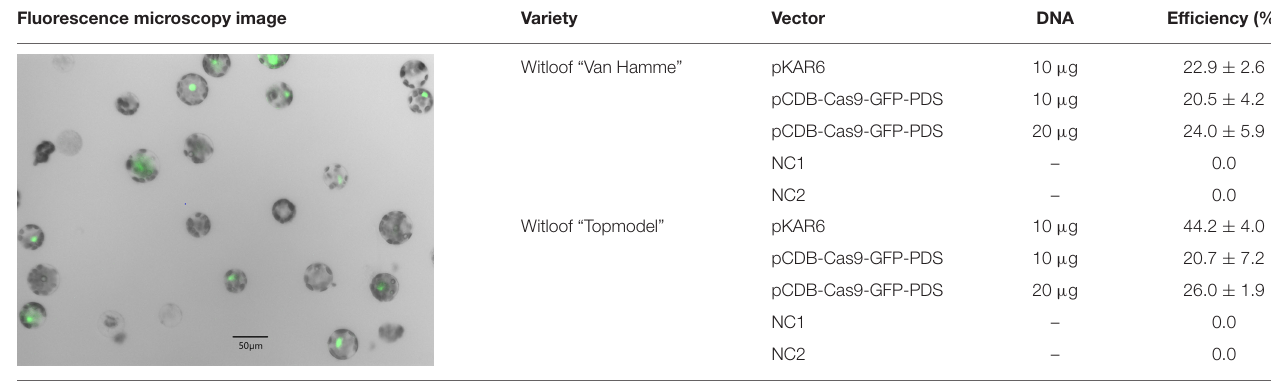
TABLE 1 | Fluorescence microscopy image of witloof “Van Hamme” protoplasts transfected with pCDB-Cas9-GFP-PDS (left panel) and transfection efficiencies with the pCDB-Cas9-GFP and pKAR6 vector (right panel). Fluorescence microscopy image